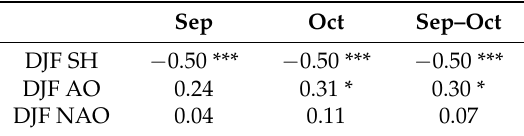
Table 1. Correlations between the autumn sea ice index and the winter arctic atmospheric circulation. Correlation coefficients over 90%, 95%, and 99% confidence levels are represented by *, ** and ***, respectively. DJF is December–January–February, SH is Siberian high, AO is arctic oscillation, NAO is North Atlantic oscillation.